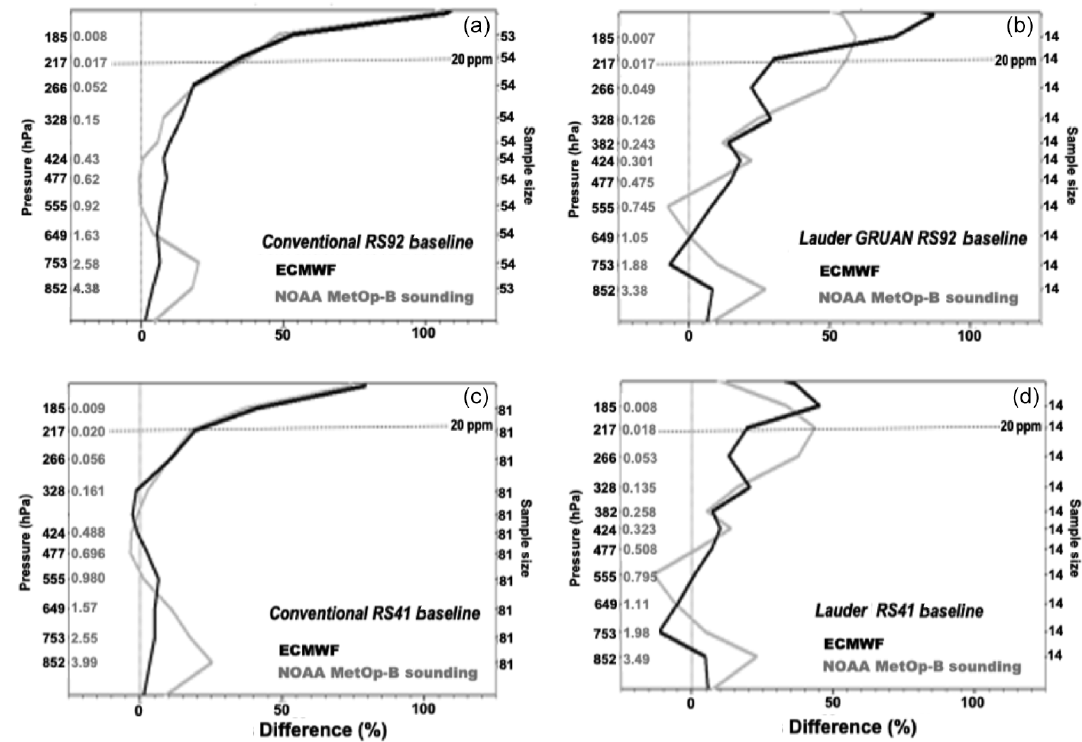
Figure 8. Mean biases between water vapor profiles from ancillary and radiosonde data from the RS92 (a, b) and RS41 (c, d) . The relative differences are expressed as 100% × (WVMR anc − WVMR radiosonde ) / WVMR radiosonde . Grey trace: differences with satellite observations from IASI MetOp-B; solid black trace: differences with associated ECMWF analysis data. (b, d) The results for RS92–RS41 twin soundings performed at the GRUAN site in Lauder, New Zealand; only the RS92 data are GRUAN-processed. (a, c) The results for conventional RS92 and RS41 radiosoundings performed during a 10d period in October–November 2017 at selected WMO sites in Europe (35–65 ◦ N, 10 ◦ W– 40 ◦ E). Collocation criteria: less than 1h (2h for ECMWF data) at approximately 500hPa within 50km at the surface. The labels at the y axis depict the pressure level (black); the average water vapor mixing ratio (gkg − 1 ) is given in grey. The numbers at the right-hand y axis represent the number of coincident observations at each pressure